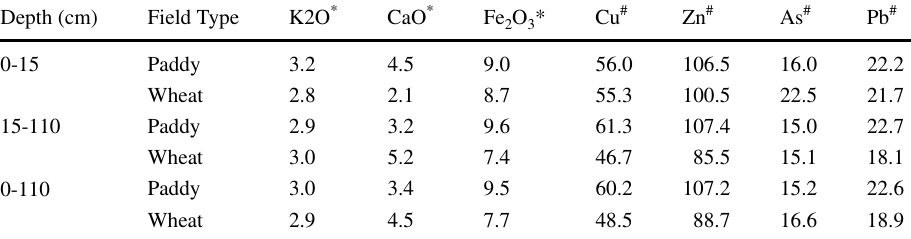
Table 1 Statistical summary of concentrations of various elements along paddy and wheat soil profile